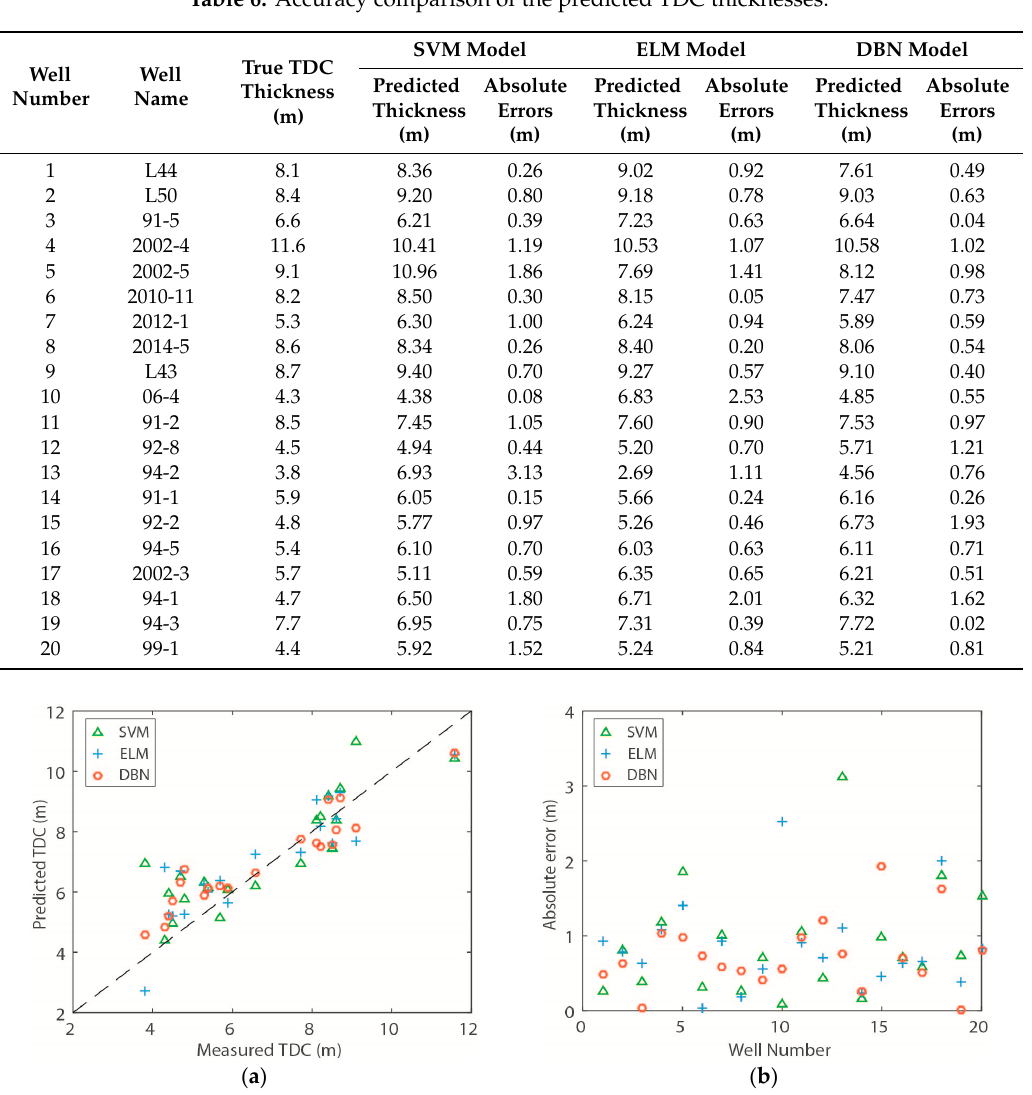
Figure 9. Comparisons of the measured and predicted TDC thicknesses ( a ) and the TDC-thickness errors ( b ) after classical